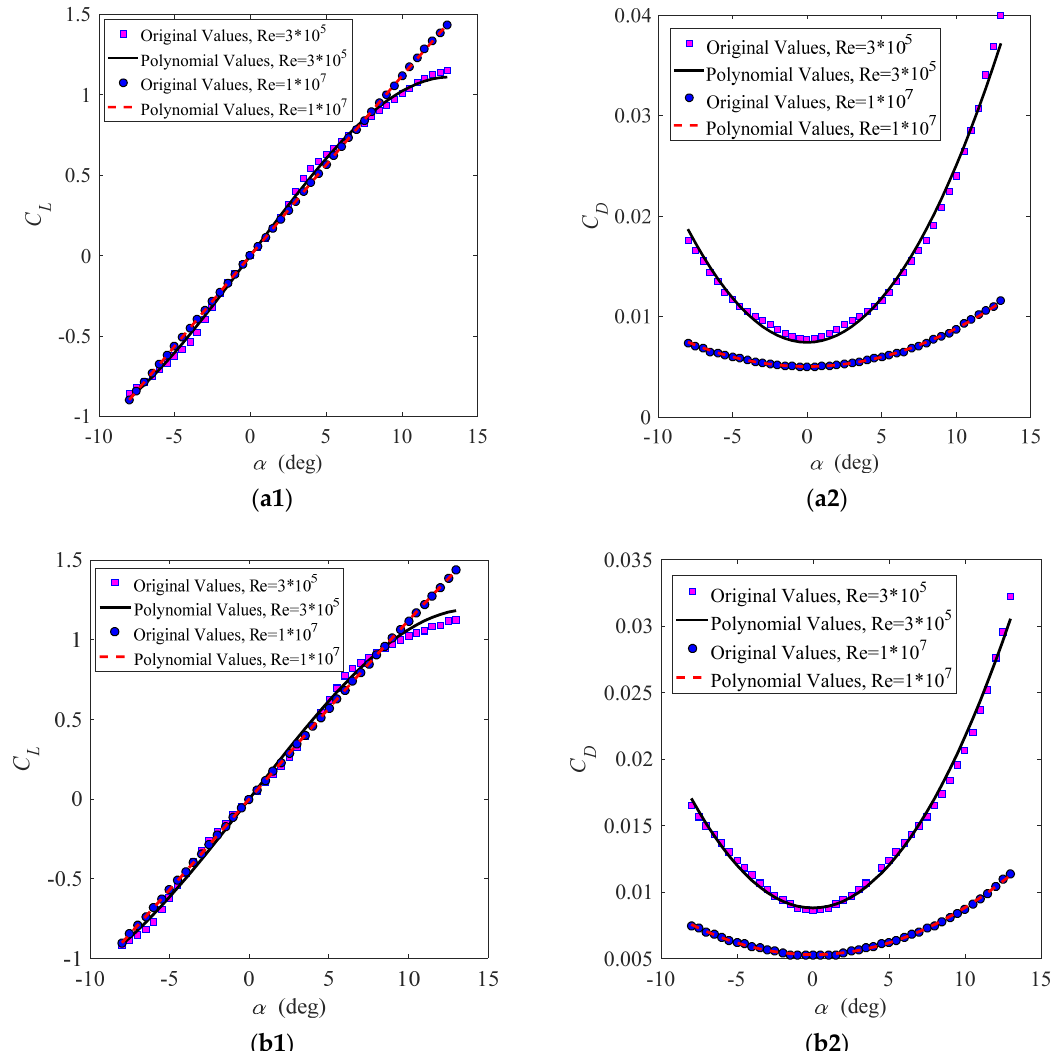
Figure 7. Comparison of original and polynomial values of C L and C D curves for symmetric airfoils: ( a1 , a2 ) the NACA0012 airfoil; and ( b1 , b2 ) the NACA0015 airfoil.